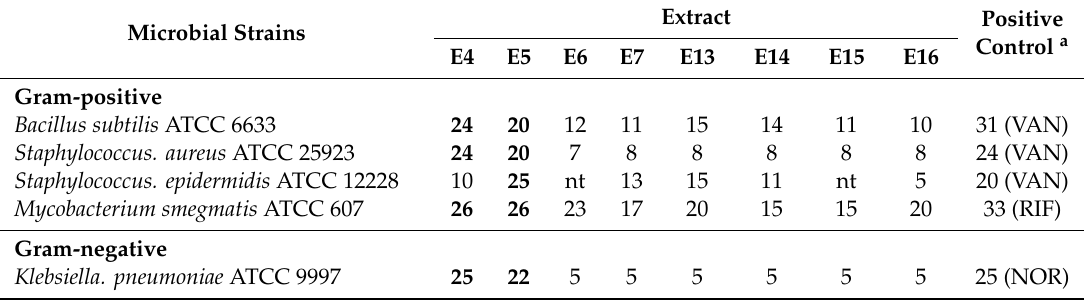
Table 2. Diameter (mm) of microbial growth inhibition by bioactive extracts (10 mg / mL) in the well di ff usion